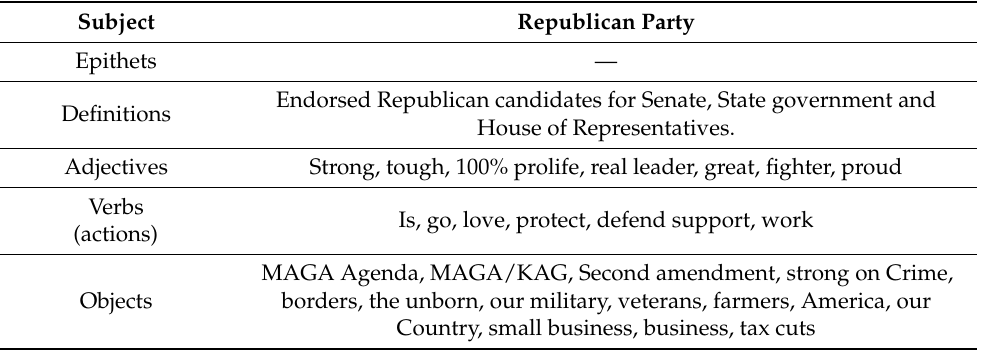
Table 9. Republican Party.